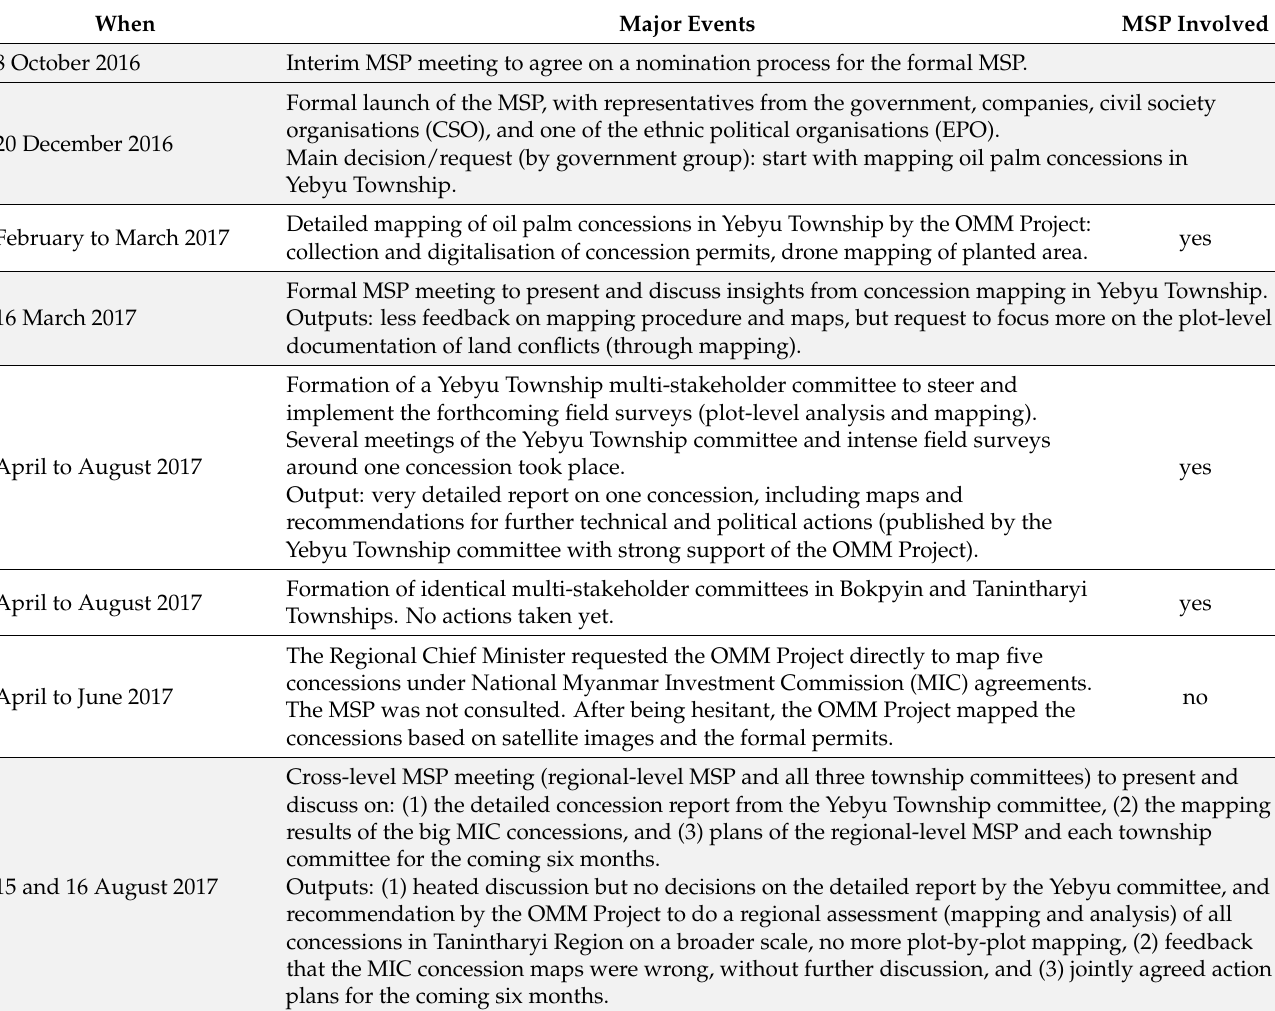
Table 1. Major events in the multi-stakeholder platform (MSP) process and in the land governance related to the palm oil